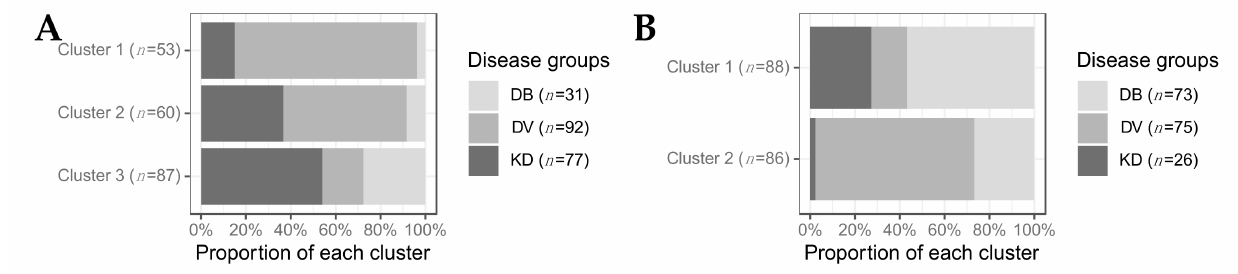
Figure 2. The proportion of patients from each disease group in each cluster for transcriptomics ( A ) and proteomics ( B ). DB, DV and KD represent definite bacterial, definite viral, and Kawasaki